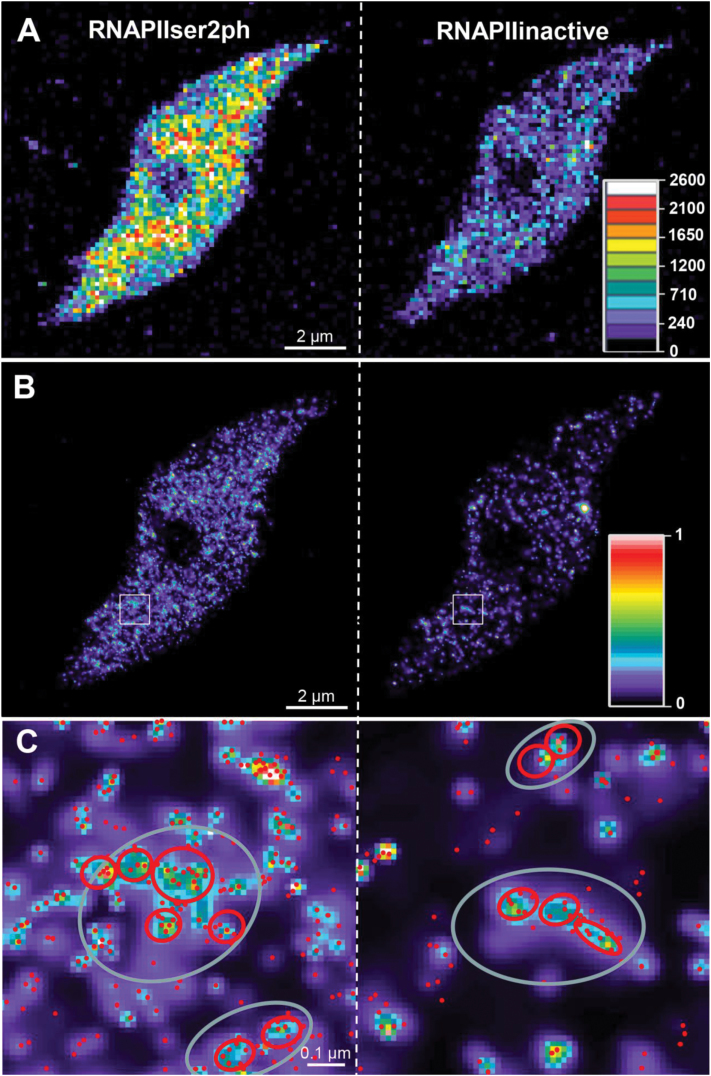
Distribution of inactive and active RNAPII molecules in an 8C A. thaliana nucleus (Nucleus 1 in Supplementary Table S1C at JXB online) recorded by 3D-PALM. (A) Density map of inactive (not phosphorylated) and active (phosphorylated at Ser2) RNAPII in a 110nm slice. The density colour code represents molecules per μm3. (B) Gauss-rendered (displayed in a heat map; 1=100% intensity) 3D-PALM images to emphasize intensity differences. (C) Enlarged image of the area boxed in (B) showing the intensity distribution (see the scale in B) with localized molecules (red dots) within the heat map. Short distance clusters are encircled in red, long distance clusters in grey.